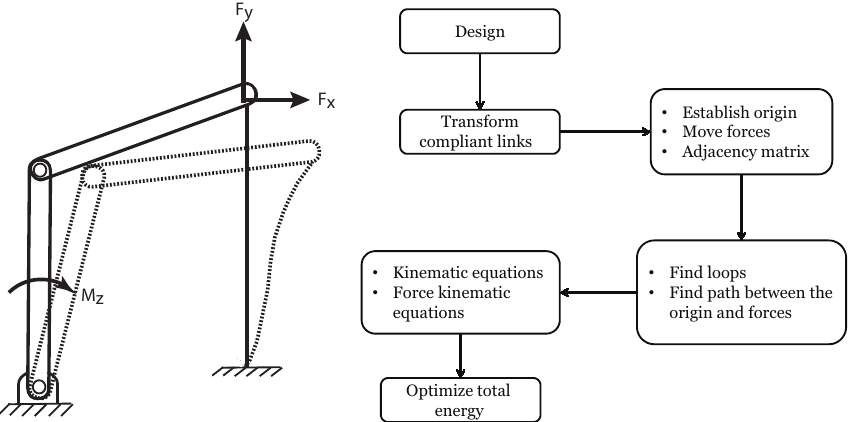
Figure 5. The schematic view (left) and flowchart (right) of the static force analysis problem. F x , F y and M z represent known loads exerting on the